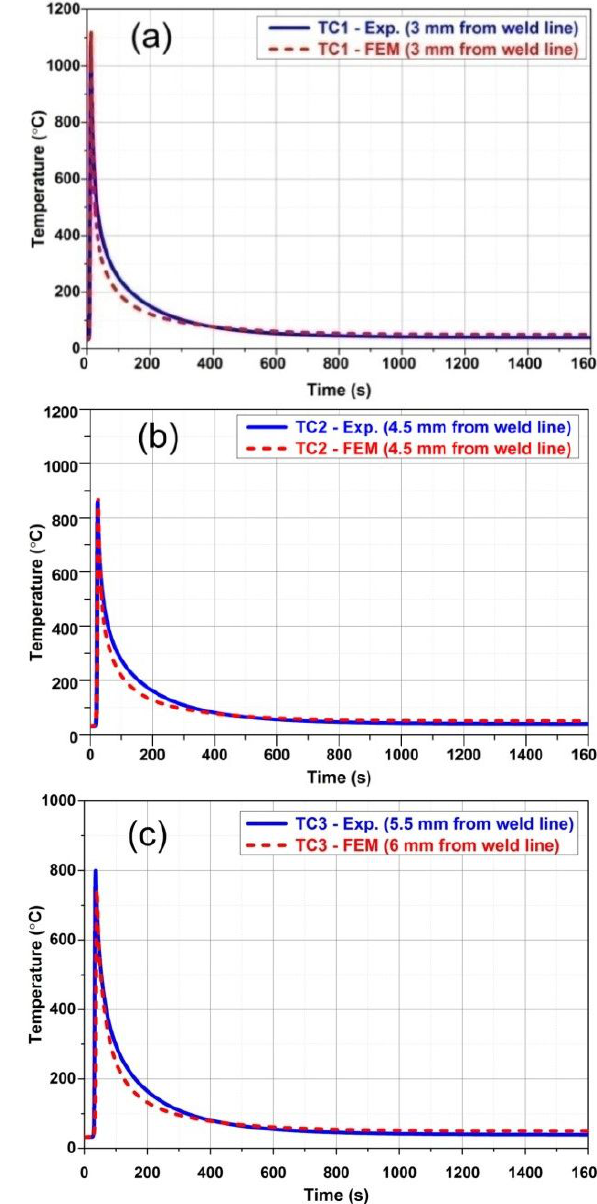
Figure 5: Comparison of temperatures in experiment and simulation (TC1, TC2 and TC3)